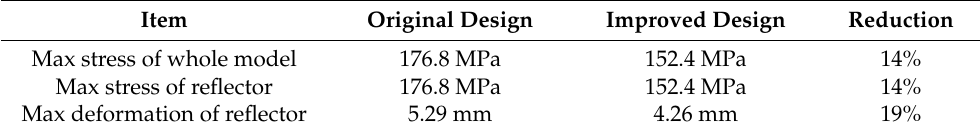
Table 1. Comparison result list between original design and improved design.